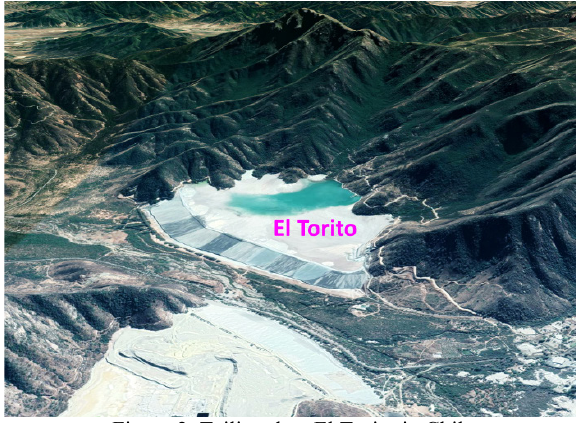
Figure 2. Tailing dam El Torito in